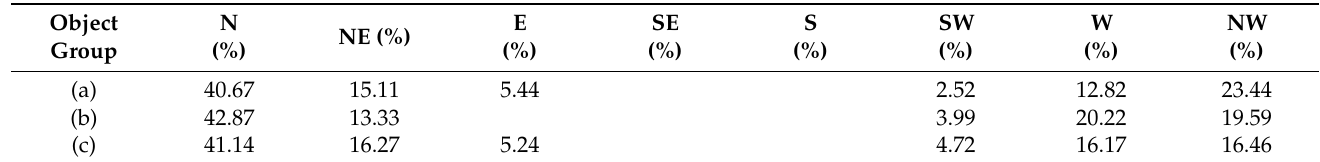
Figure 10. Object group generalization: ( a ) original data, ( b ) the first generalization, and ( c ) the second generalization. Table 1. Computation results of the direction relationship.